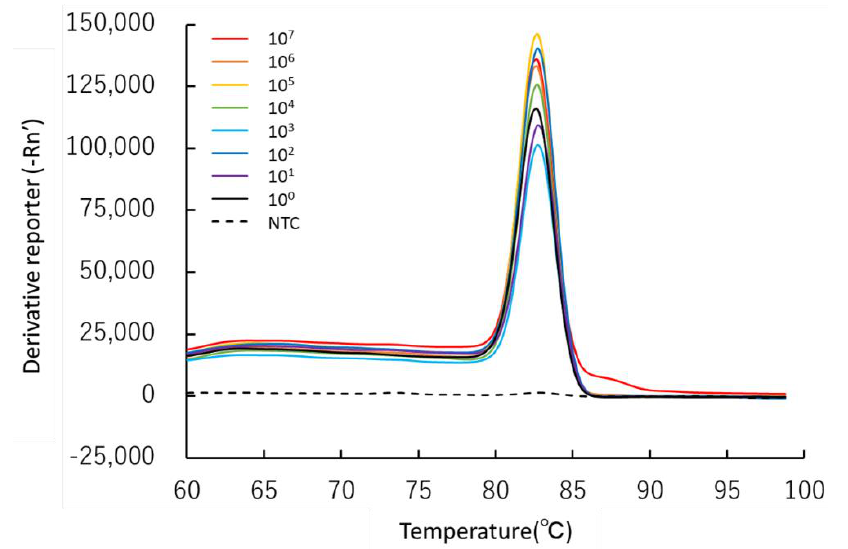
Figure 4. Melting curves of recombinant plasmid DNA containing genomic sequences from Serpula himantioides amplicons as determined by real-time PCR. The derivative reporter, displayed on the y-axis, was calculated as the negative first derivative of the normalized fluorescence (Rn) generated by the reporter during PCR amplification. For visual clarity, the mean of the derivative reporter is shown ( n =